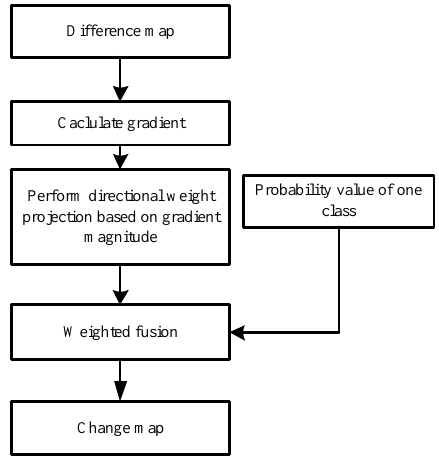
Figure 6. Flowchart of the post-processing